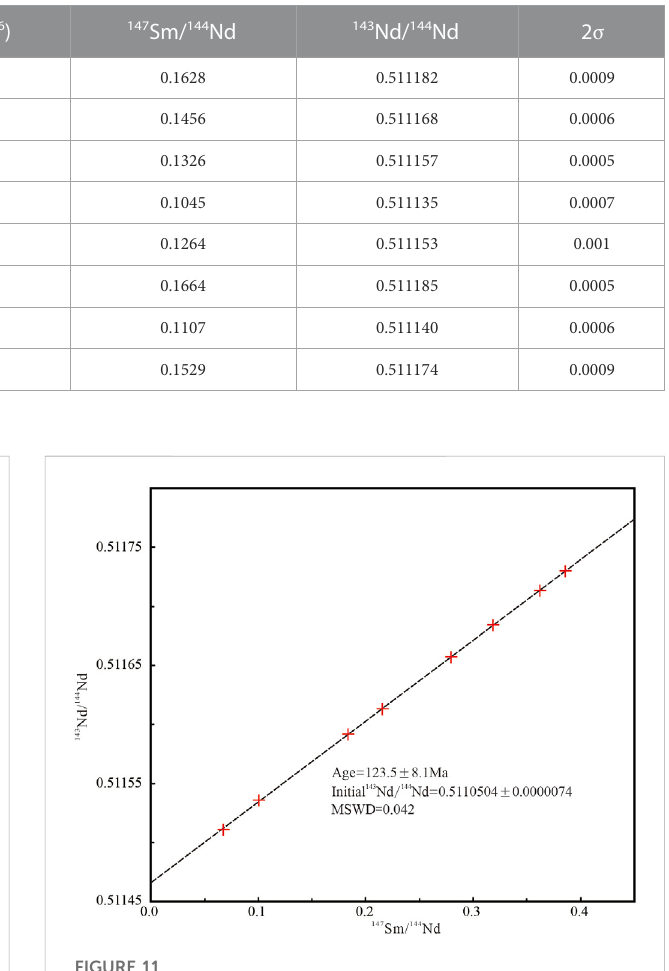
FIGURE 11 Diagram of calcite Sm-Nd isochronous age for the Yangjiakuang gold deposit.